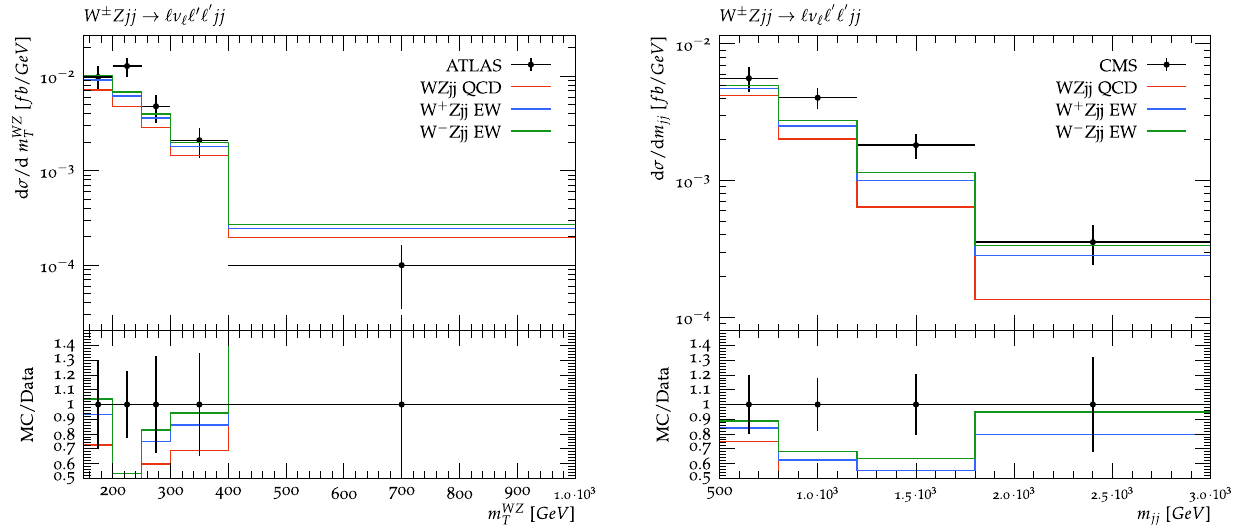
Fig. 5 The W ± Zjj production measurements from ATLAS [17] (left) and CMS [15] (right). In both cases the EW-induced induced contributions, which are being added to the QCD-induced ones, are separated into W + Zjj and W −